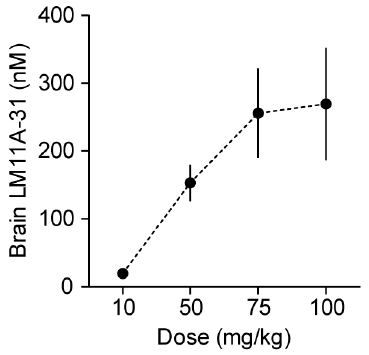
Figure 2. Brain concentrations of LM11A-31 delivered ad libitum in drinking water of C57BL/6 mice. LM11A-31 was given to C57BL/6 mice ad libitum in drinking water for 3 weeks at targeted doses of 10, 50, 75 and 100 mg/kg/day (n=3–4 mice/dose). Brain concentrations were determined by LC-MS/MS by Absorption Systems (Exton, PA).